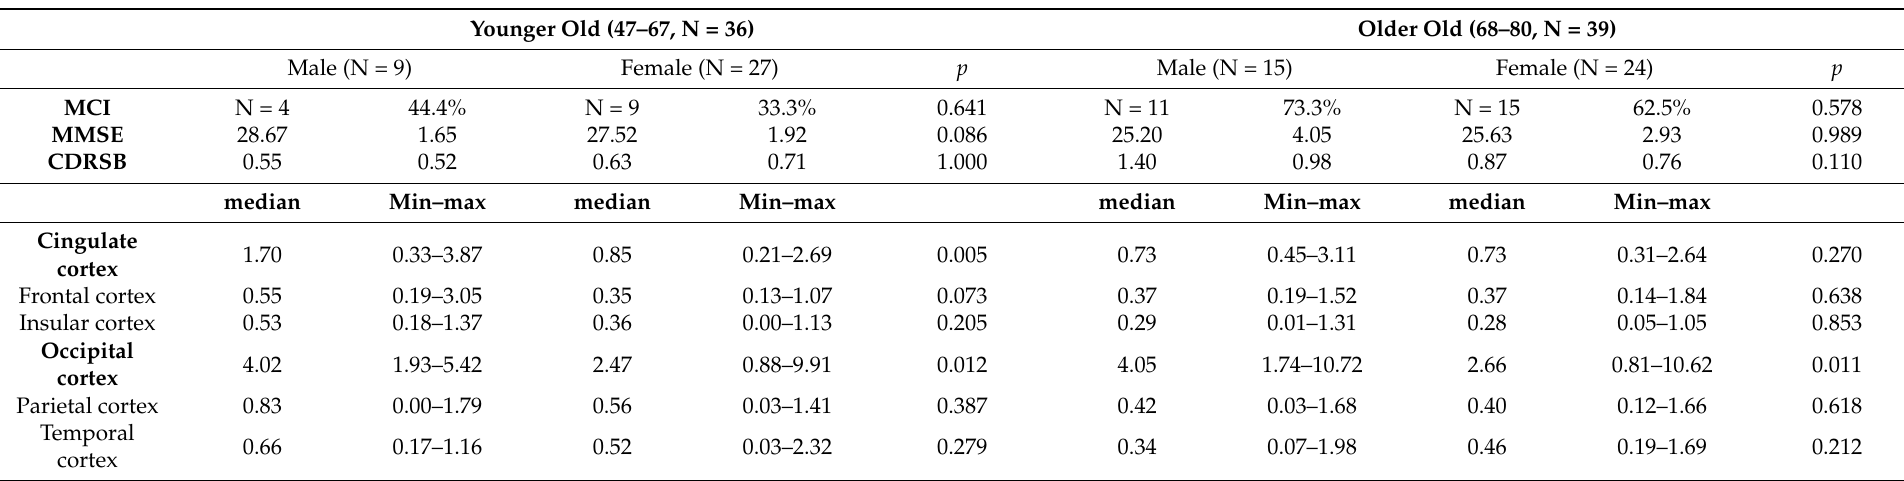
Table 3. Comparison of cerebral regional K trans according to the sex, when stratified by